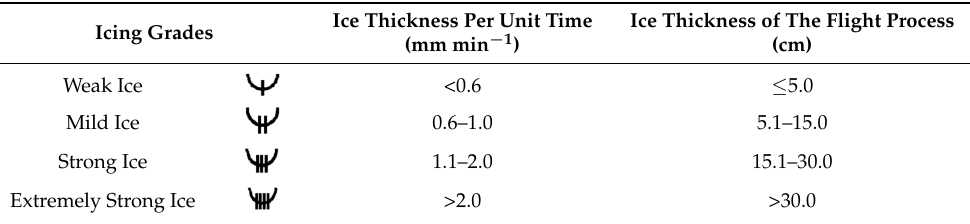
Table 1. Aircraft icing level classification.